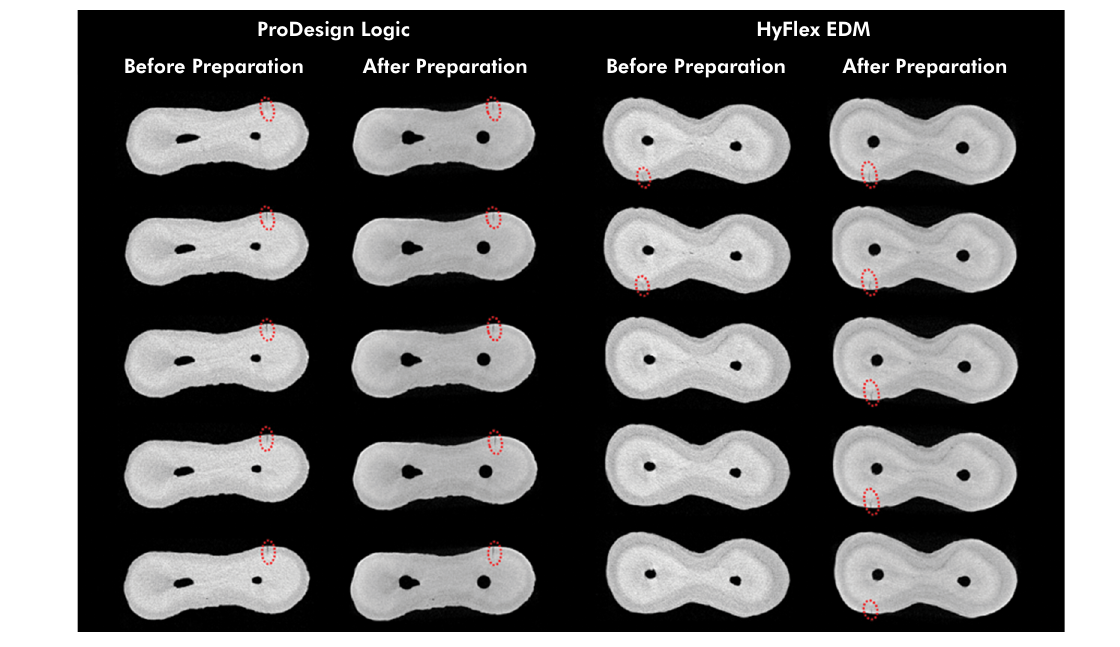
Figure 3. Representative cross-sectional micro–CT images, at 5 µm voxel size, showing microcrack continuity with a 50 µm interval between slices, before and after instrumentation with the ProDesign Logic and HyFlex EDM systems. Microcracks are circled in